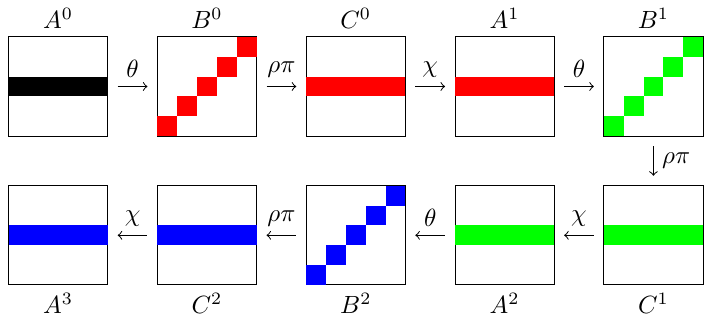
Figure 7: Representation of 3 rounds of Ketje . Each colored part corresponds to lanes that can be directly computed known from the 4 known output